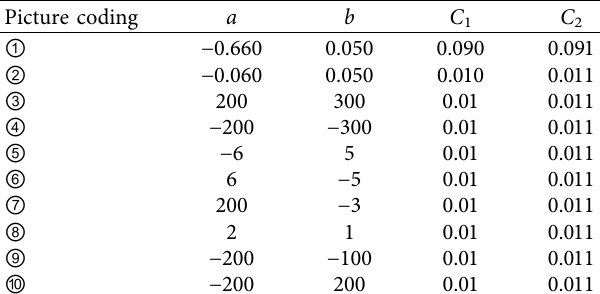
Table 3: Initial setting of parameters for horizontal